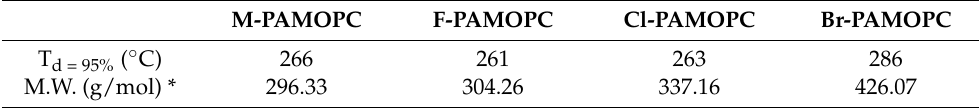
Figure 2. TGA curve of the synthesized azo pyridine derivatives. Table 4. The degradation temperature and molecular weight of newly synthesized compounds.